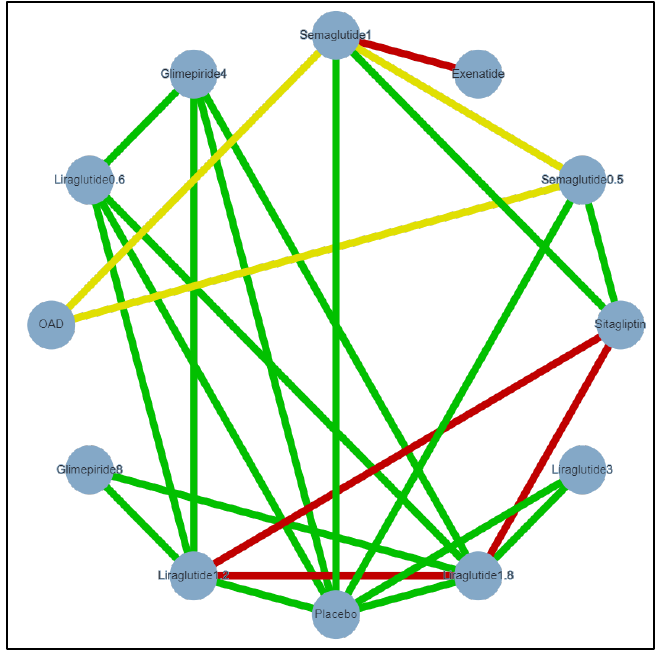
Figure 3. Evidence network of included studies for weight analysis. Semaglutide 1 = Semaglutide